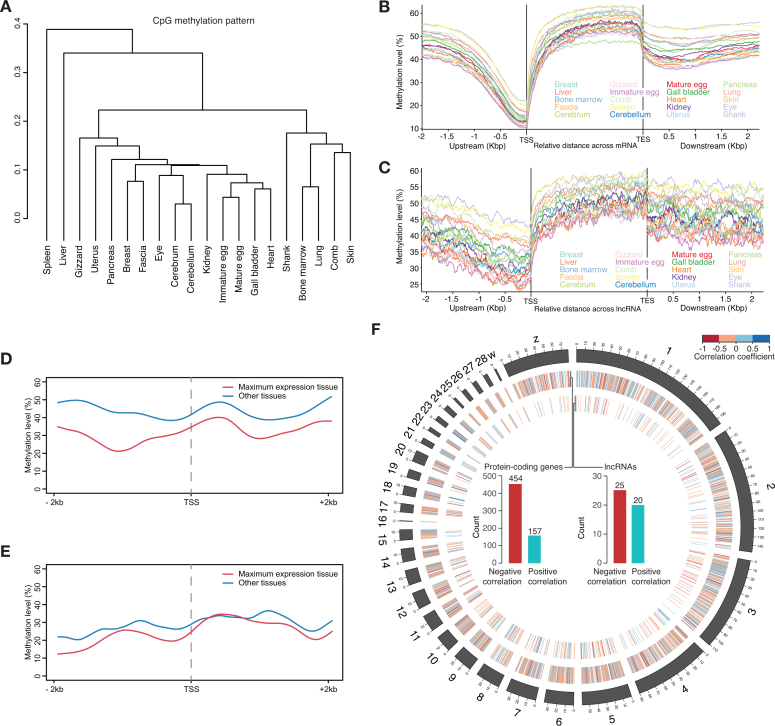

(A) Hierarchical clustering using Pearson correlation of DNA methylation patterns between tissues. (B and C) Average DNA methylation landscapes along protein-coding (B) and lncRNA (C) gene bodies and their flanking regions across 20 tissues. (D and E) Average DNA methylation levels of protein-coding (D) and lncRNA (E) genes in the tissue of maximum expression (red) and the other tissues (blue). (F) Spearman correlation coefficients between gene expression and promoter methylation levels are shown across chromosomes (heat maps) in a Circos plot. The bar charts indicate the number of genes (left for protein-coding genes and right for lncRNAs) with significant negative (red) and positive (cyan) correlations (P < 0.05) between their promoter methylation levels and their expression values.